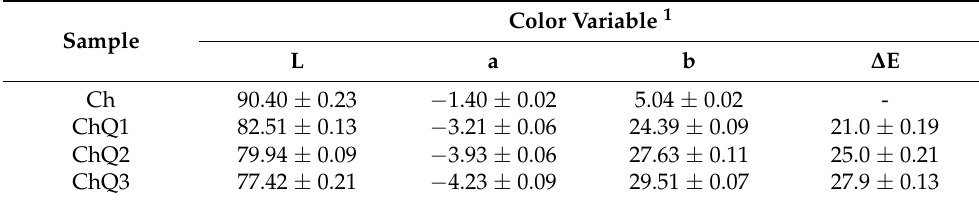
Table 3. Color variables of studied